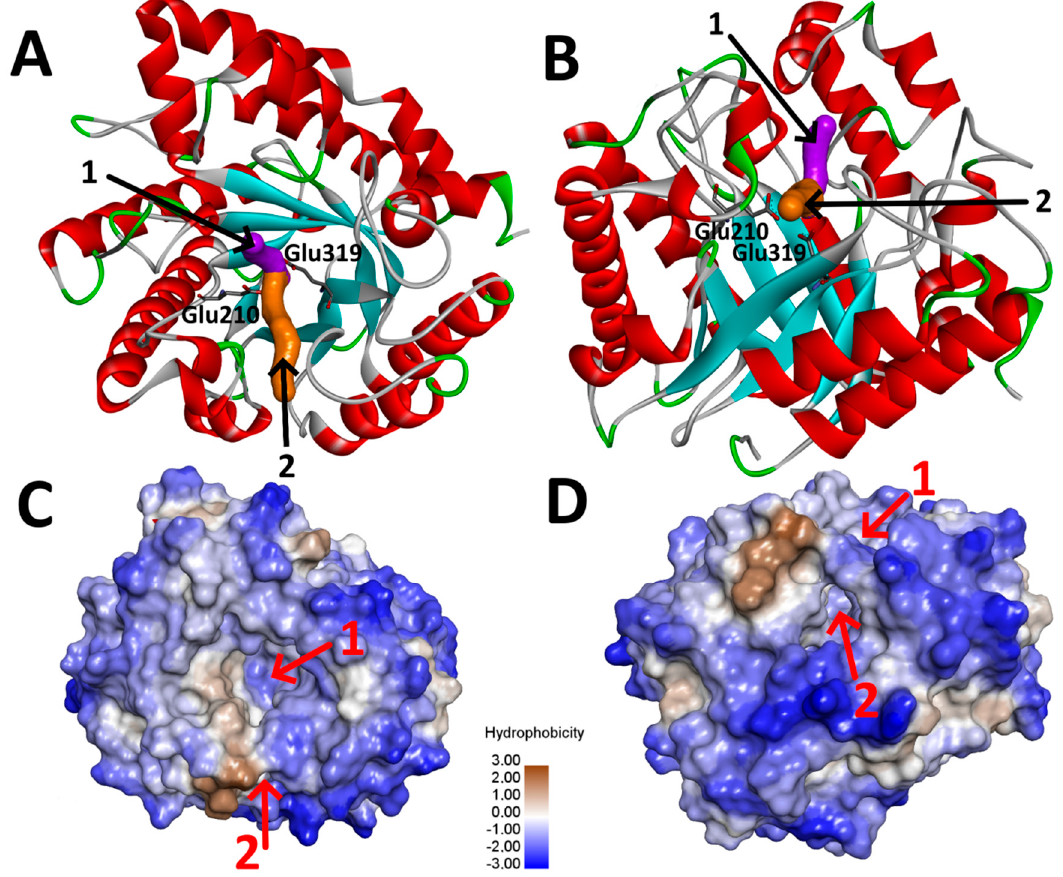
Figure 3. Tunnels leading to the active site of AnRut protein (PDB ID: 6I1A) . ( A , B ) Main (magenta) and side (orange) tunnels within the ribbon model, the active site residues Glu319 and Glu210 are shown as stick models; ( C , D ) The views of the main (1) and side tunnels (2) within the hydrophobic surface model.